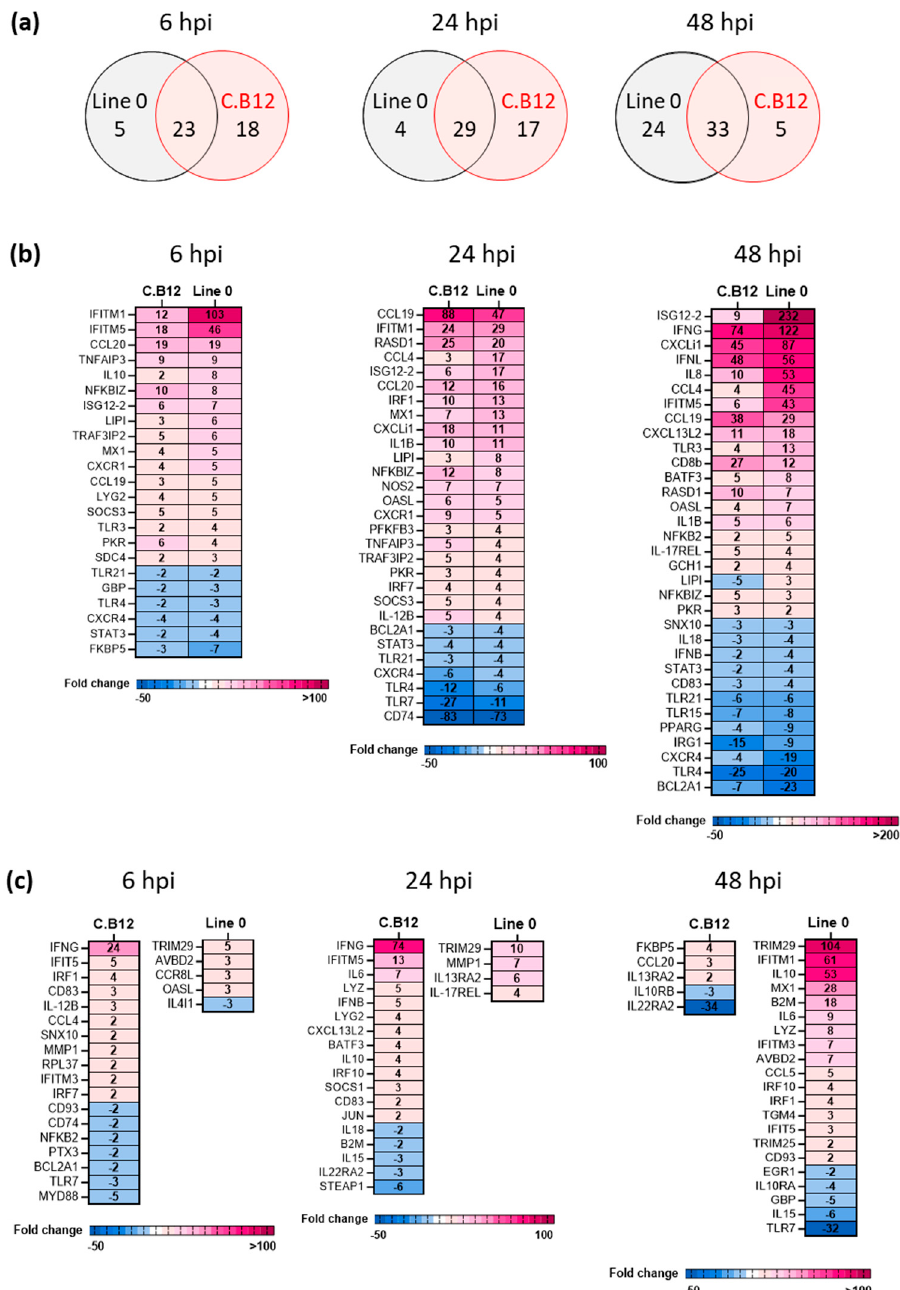
Figure 7. H7N1 infection of lung macrophages shows differences in the immune response kinetics and intensity between susceptible and resistant lines. Significant DEGs were identified by comparing the relative expression values for H7N1-infected lung macrophages to their corresponding mock control, and this was performed intra-line (i.e., C.B12 infected v C.B12 mock) and individually per timepoint, with a significance level set at p < 0.05; fold change >1 (n = five/line/time-point). ( a ) Venn diagrams presenting unique and shared numbers of significant DEGs of line 0 and line C.B12 in response to H7N1. ( b ) Heatmaps illustrating the fold change associated with significant DEGs that are shared among line 0 and line C.B12 and are ( c ) unique to a specific line at 6 hpi, 24 hpi and 48 hpi. Fold change values are represented on a divergent, intensity colour scale showing the expression of upregulated genes (pink) to downregulated genes